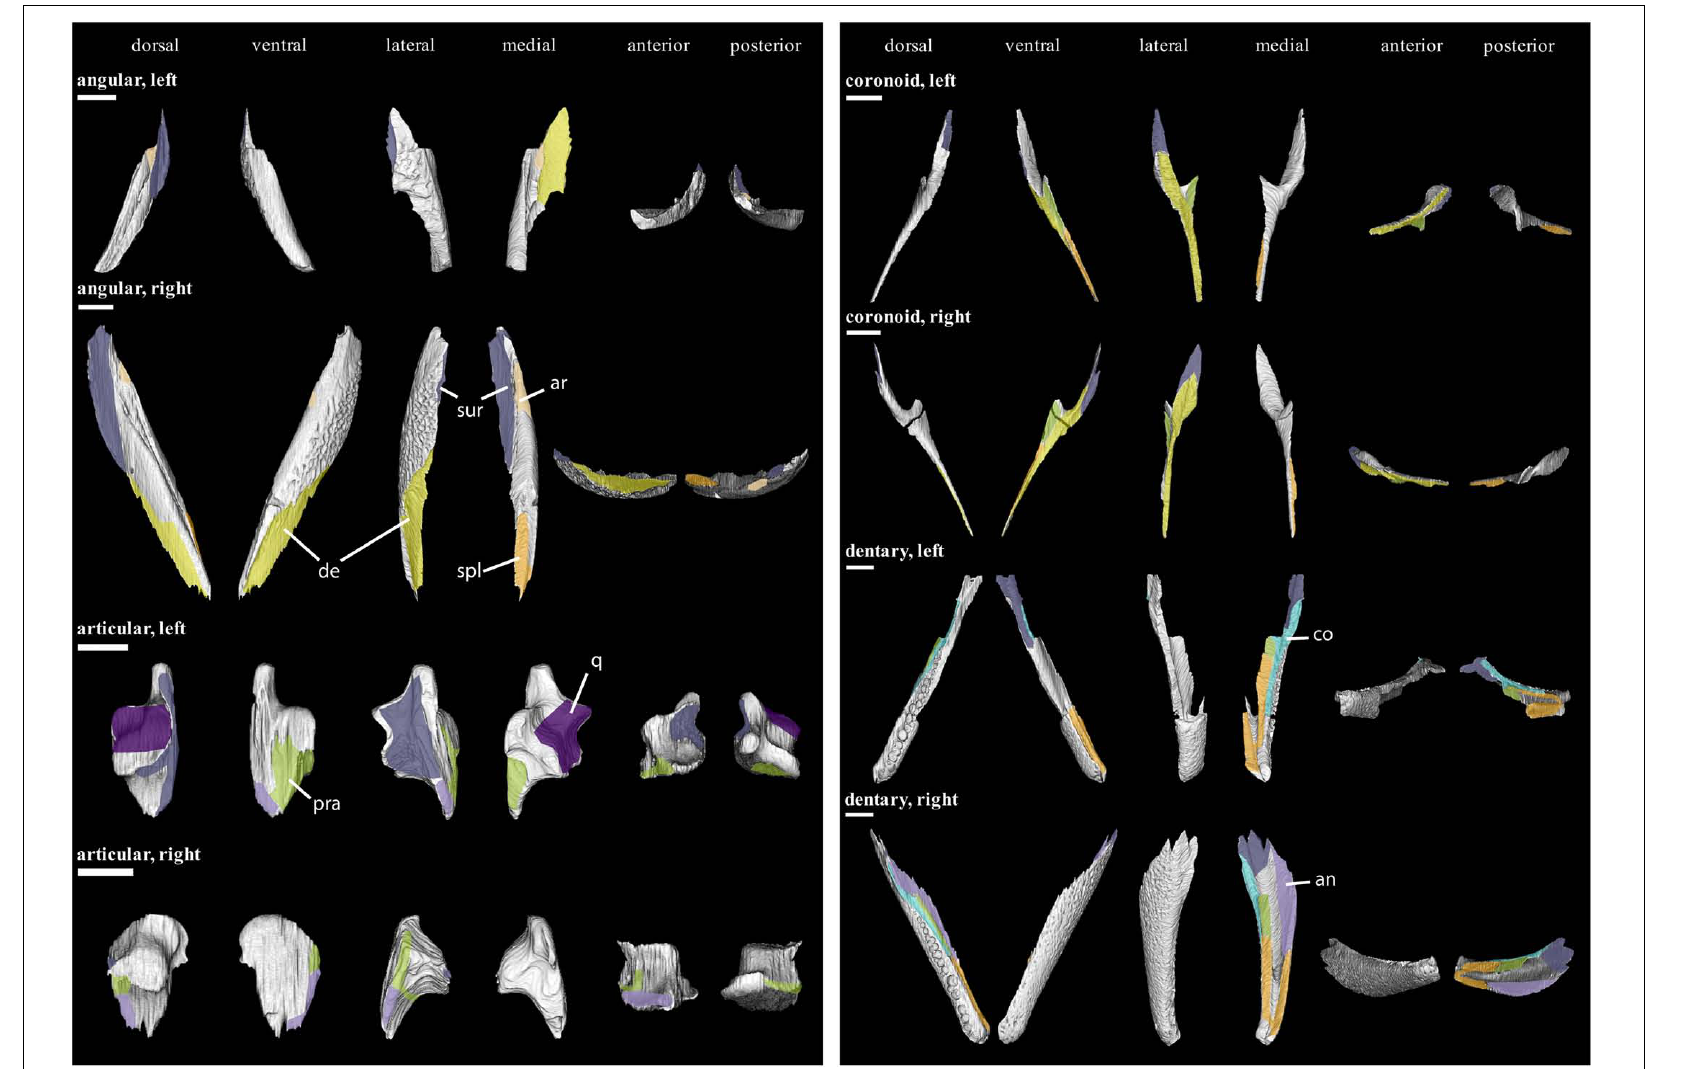
FIGURE 3 | Isolated bones in dorsal, ventral, lateral, medial, anterior and posterior views. Articulation areas with other bones are colored. Left and right angular, left and right articular, left and right coronoid, and left and right dentary are shown. Scale bar = 10 mm. For abbreviations see caption to Figure 1